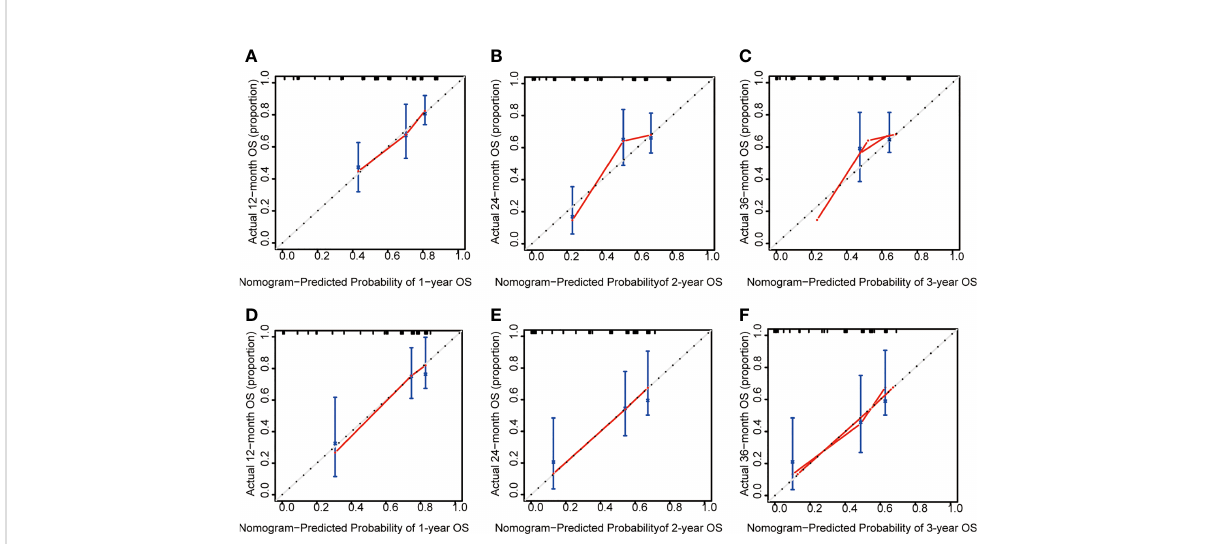
FIGURE 6 The calibration plot of ALL patients. (A) Calibration analysis of the training cohort at 1-year. (B) Calibration analysis of the training cohort at 2- year. (C) Calibration analysis of the training cohort at 3-year. (D) Calibration analysis of the validation cohort at 1-year. (E) Calibration analysis of the validation cohort at 2-year. (F) Calibration analysis of the validation cohort at 3-year. OS, overall survival.